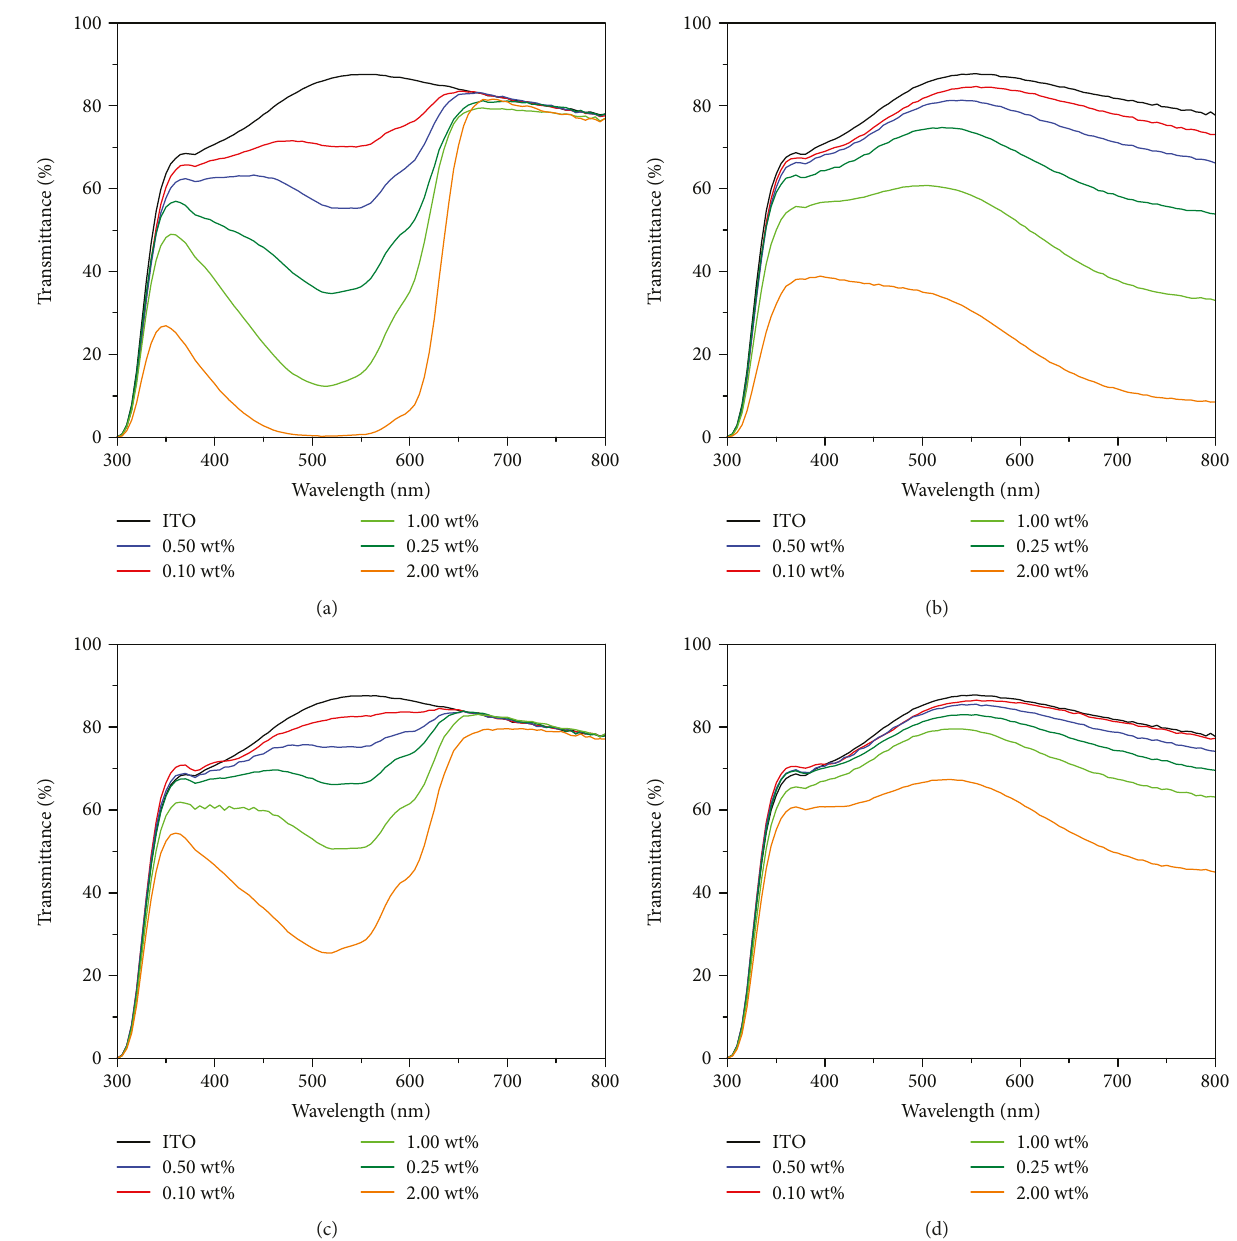
Figure 5: Light transmittances of the spin-coated P3HT fi lms on the ITO substrates according to the solution concentrations, in the range of 300nm to 800nm. The spin-coating processes were performed using (a, b) chloroform and (c, d) chlorobenzene as solvents, respectively. The spectra in (a) and (c) correspond to the P3HT oxidation (red) states, and the spectra in (b) and (d) correspond to the P3HT reduction (blue)